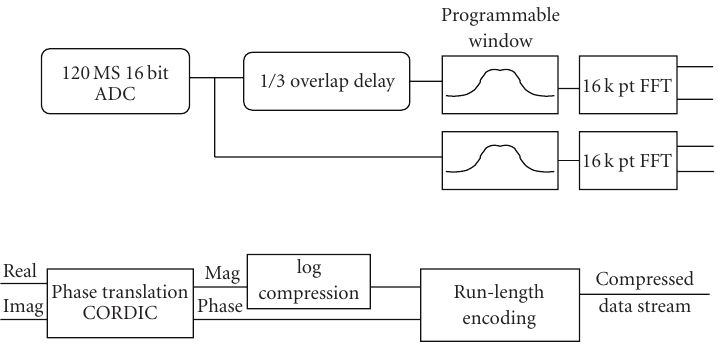
Figure 13: Application architecture for Gabor transform-based wideband compression system.